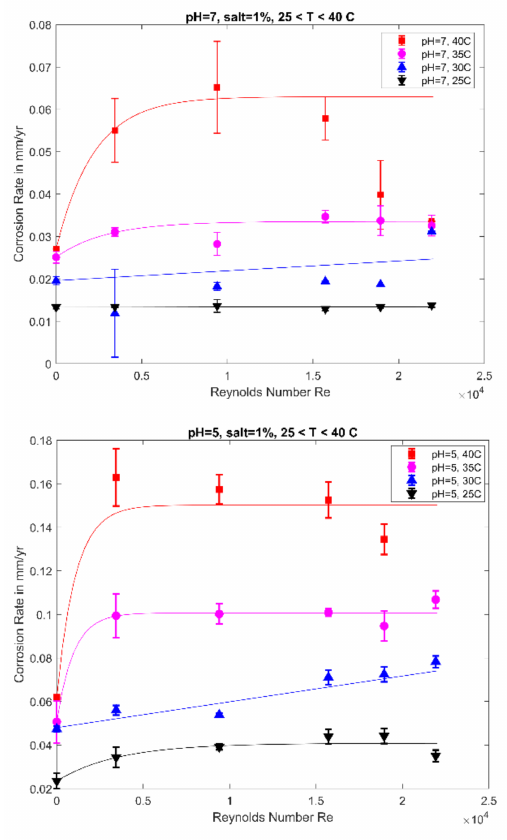
Figure 11. Corrosion rates are shown at different Reynolds number for feed solution maintained at pH–7 on the left, and at pH-5 on the right at 1% NaCl, at following temperatures (25 ◦ C, 30 ◦ C, 35 ◦ C, and 40 ◦